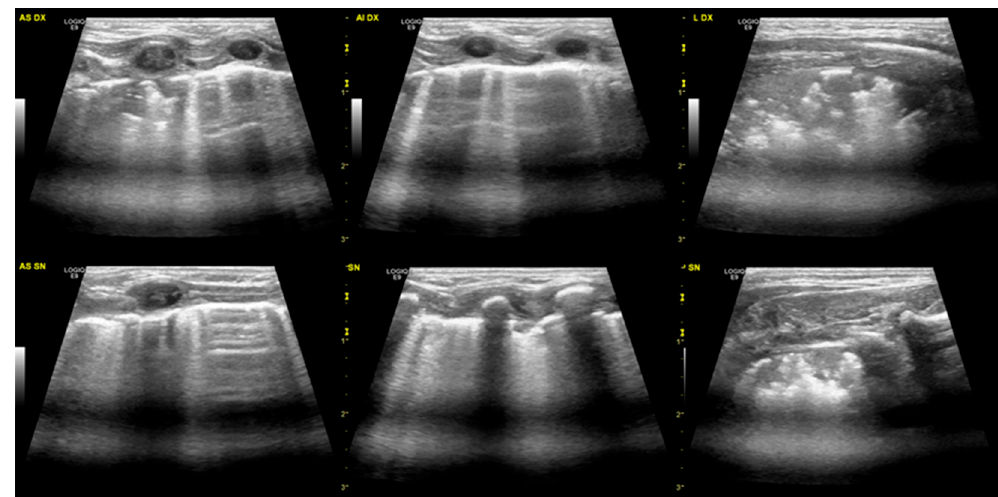
Figure 1. Typical ultrasound findings in MAS: B lines, often coalescing, and the pleural line is thickened and interrupted. Small consolidations (less than 1 cm) can be found in different areas of the lungs. At the top of the image, the right lung is shown, divided into three areas: the upper anterior, lower anterior, and lateral. In the lower portion of the image, the left lung.